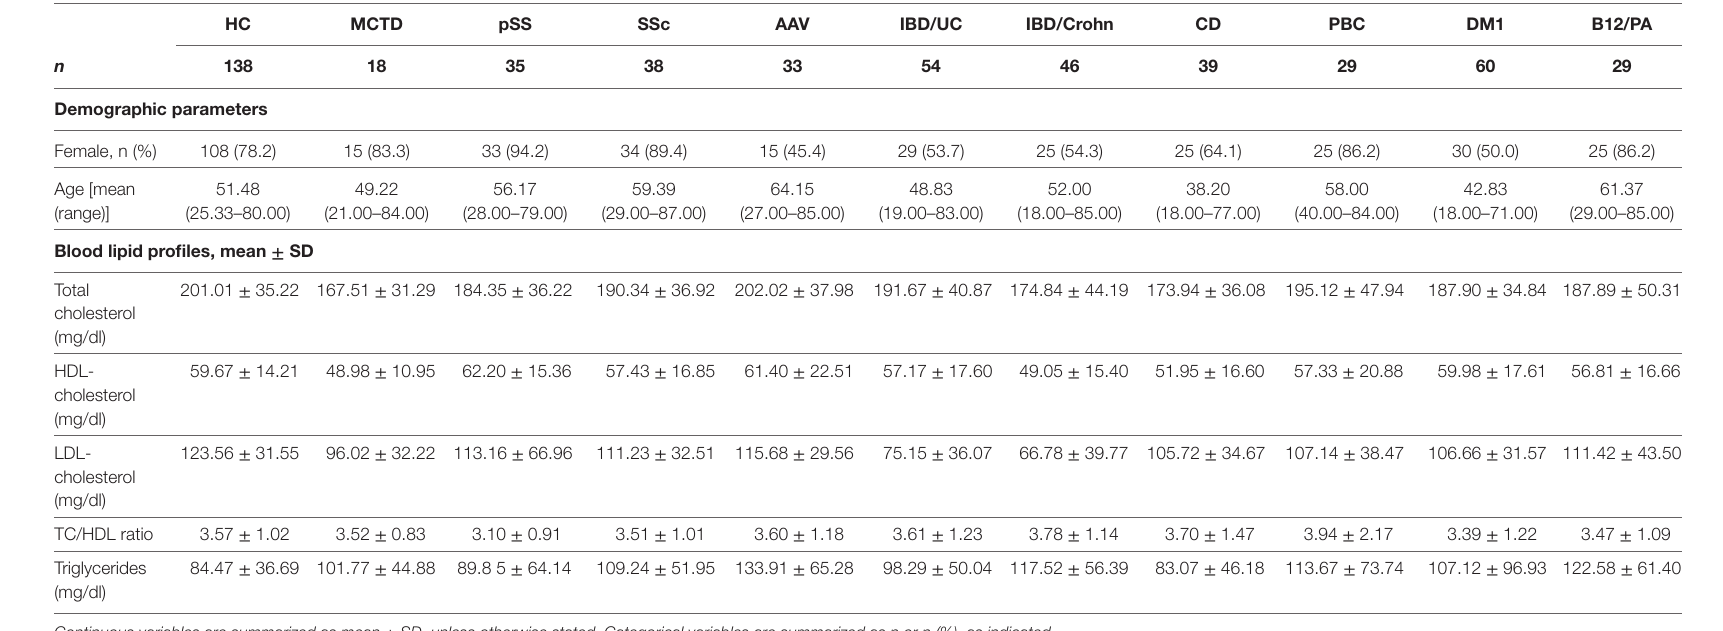
Table 1 | Demographic features and blood lipid profiles of the individuals entered in this